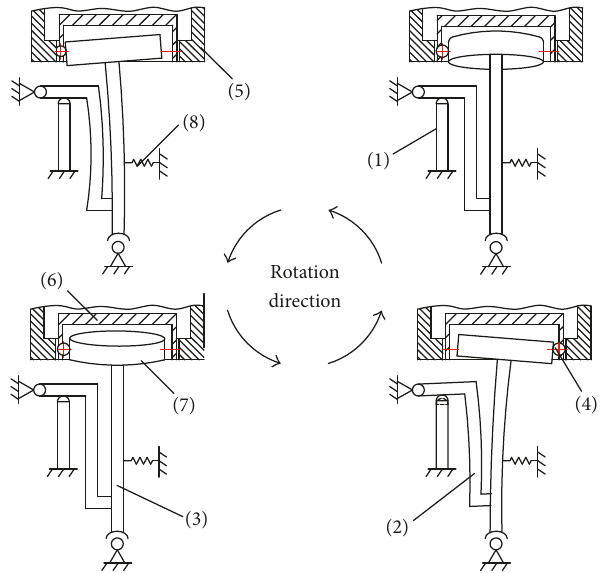
Figure 2: Working principle of movable tooth piezoelectric